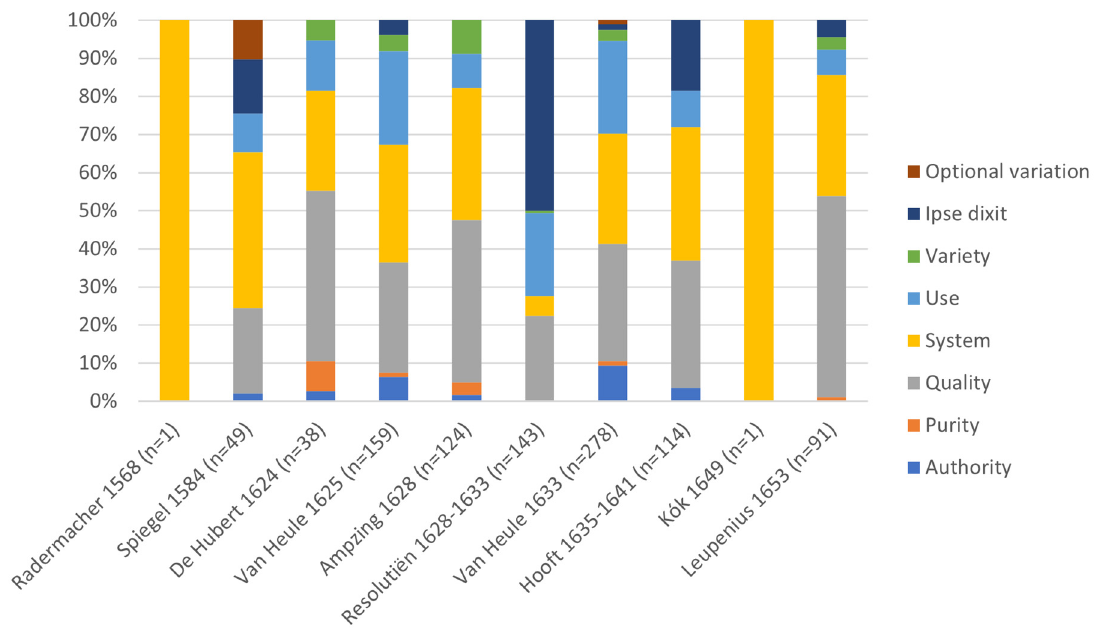
Figure 4 . Relative distribution of types of arguments per normative work (total number of arguments: n = 1011).